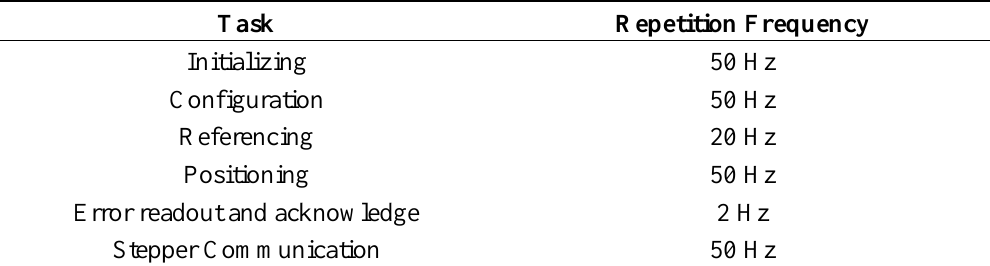
Table 2. Repetition frequencies of the PLC tasks (1 Hz = 1 repetition per second).